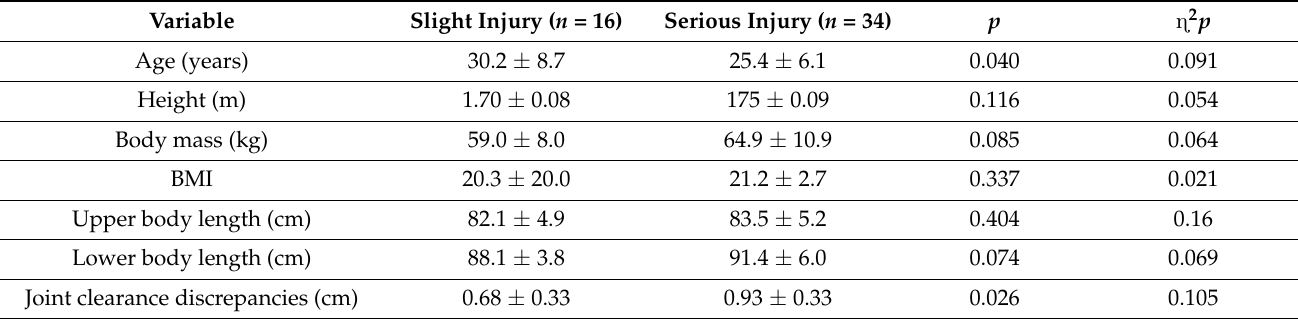
Table 6. Age and anthropometric outcomes in athletes with slight injury and serious